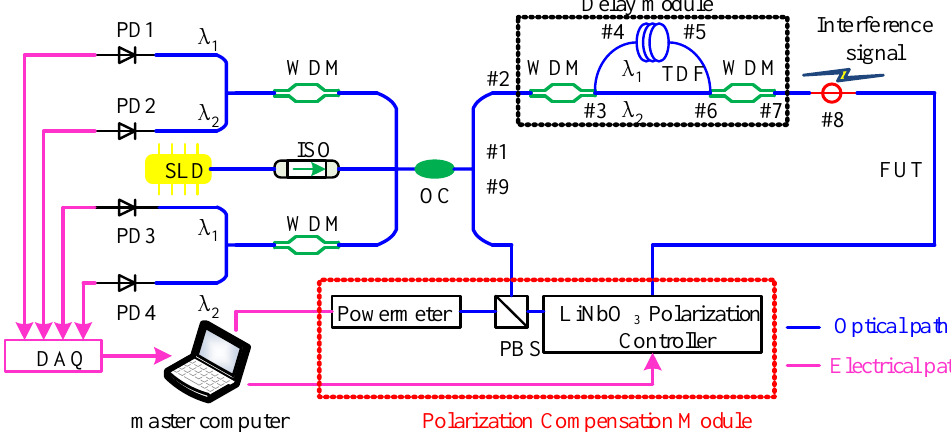
Figure 3. Optical fiber sensing system for detecting interference signal.